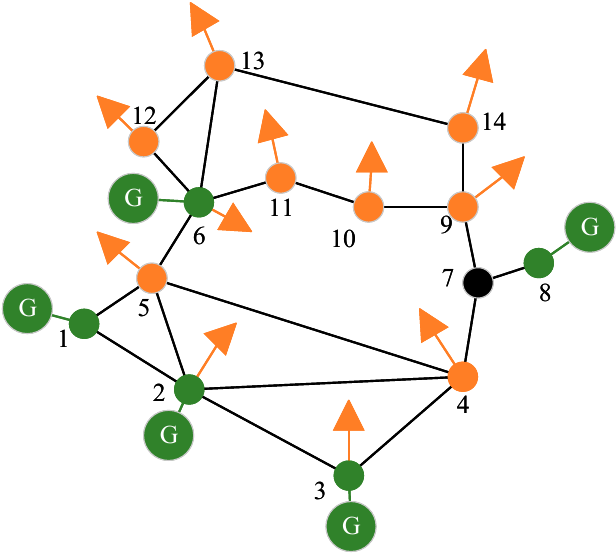
Figure 9. IEEE 14-bus test system.